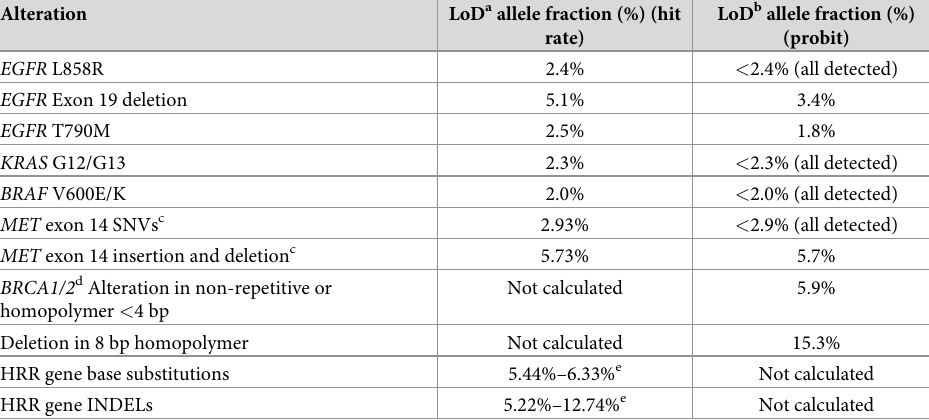
BRAF = v-Raf murine sarcoma viral oncogene homolog B; BRCA = breast cancer gene; EGFR = epidermal growth factor receptor; HRR = homologous recombination repair; KRAS = V-Ki-ras2 Kirsten rat sarcoma; LoD = limits of detection; MET = mesenchymal-epithelial transition; PIK3CA = phosphatidylinositol-4,5-bisphosphate 3-kinase catalytic subunit alpha. a LoD calculations for the companion diagnostic variants were based on the hit rate approach, as there were less than three levels with hit rate between 10% and 90% for all companion diagnostic variants (not including BRCA 1/2 variants). LoD from the hit rate approach is defined as the lowest level with 95% hit rate (worst case scenario). b LoD calculations for the companion diagnostic variants based on the probit approach with 95% probability of detection. c For each sample, five levels of MAF, with 10 replicates per level, were evaluated for a total of 50 replicates per sample. d See Summary of Safety and Effectiveness Data for